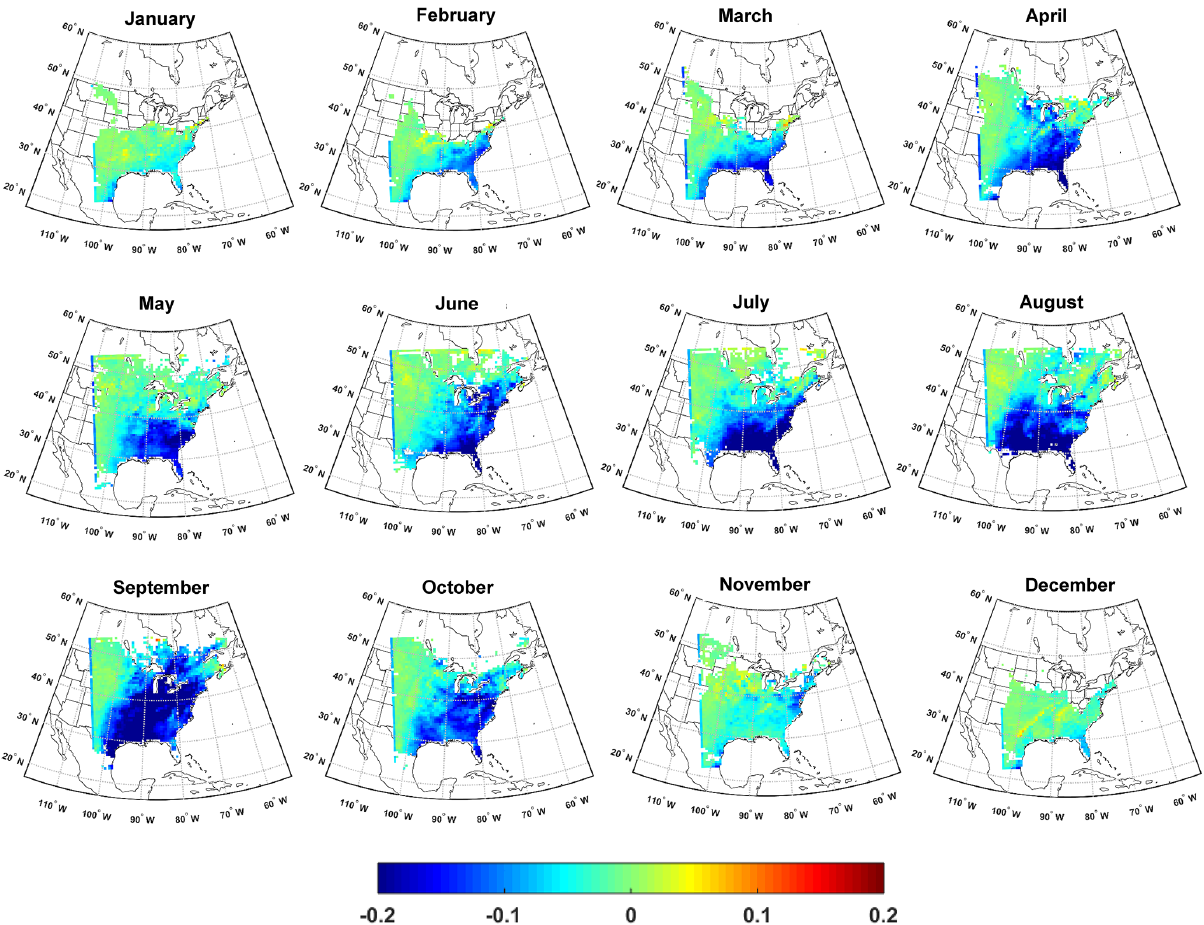
Figure 4. Difference in monthly mean AOD at a wavelength ( λ) of 550nm between WRF-Chem simulations conducted at 60km resolution (WRF60) and output from WRF-Chem simulations conducted with a resolution of 12km but remapped to 60km (WRF12-remap). Differ- ences are computed as WRF60 minus WRF12-remap. Similar spatial patterns and magnitudes of differences are found for λ of 470 and 660nm. The calendar months of 2008 are shown in the titles of each panel.